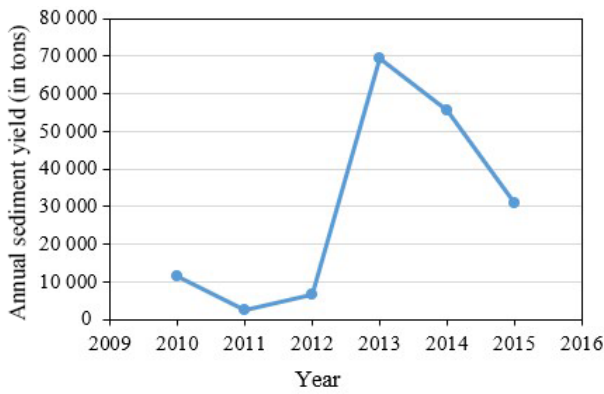
Figure 12. Simulated Annual Sediment Yield for Soapstone Branch Catchment